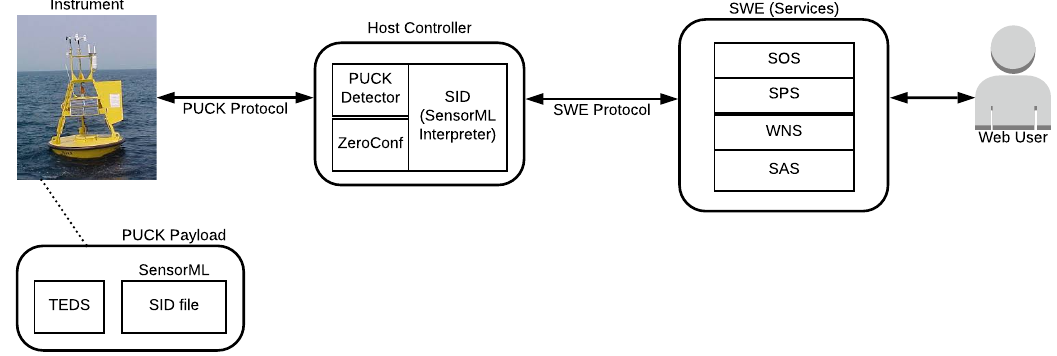
Figure 5. Plug-and-work architecture using OGC–Programmable Under Water Connector (PUCK) and Sensor Interface Descriptor